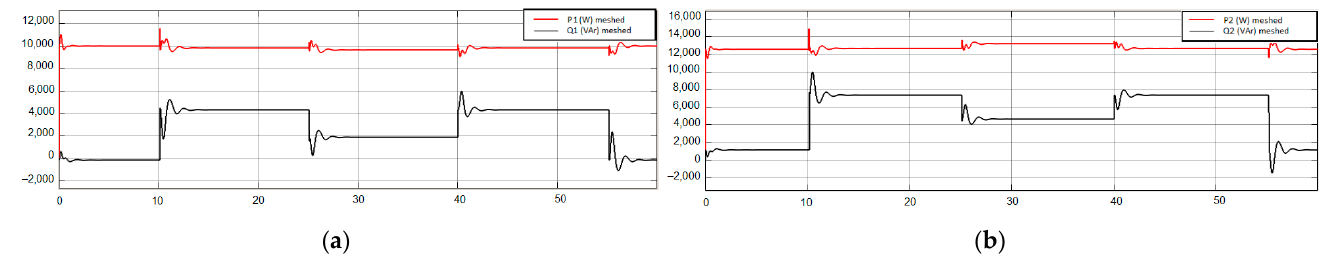
Figure 22. Simulation results for P and Q delivered by each feeder; ( a ) P and Q provided by feeder A; ( b ) P and Q provided by feeder B.